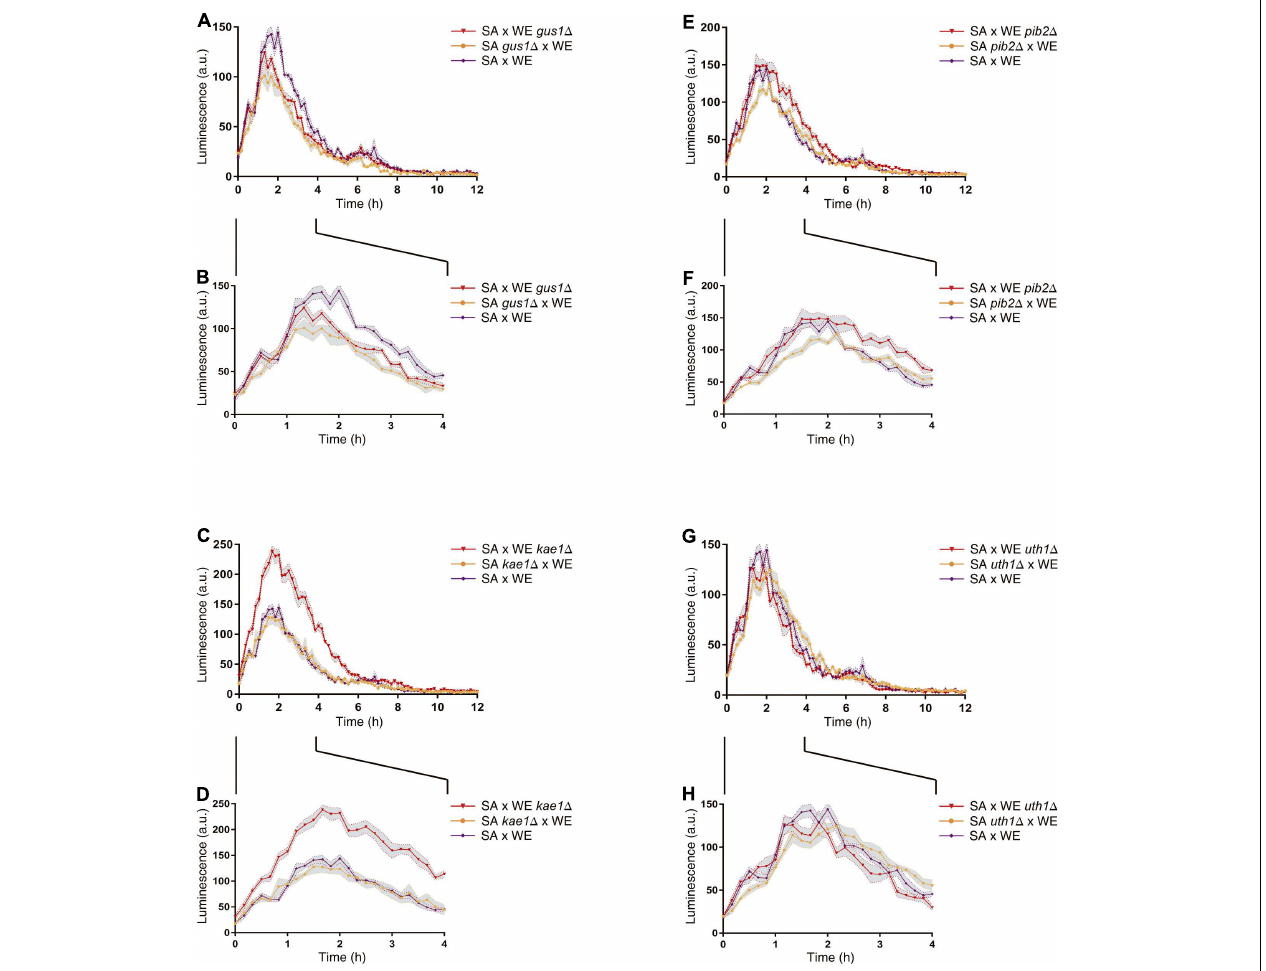
FIGURE 2 | Reciprocal hemizygosity analysis by nitrogen upshift experiments in microculture. Luminescence differences between reciprocal hemizygous strains for the genes GUS1 (A,B) , KAE1 (C,D) , PIB2 (E,F), and UTH1 (G,H) were evaluated in microculture conditions after a pulse of glutamine. The luminescence was recorded until 12 h after the nitrogen pulse (A,C,E,G) . Zoom-in of the first 4 h after the nitrogen (proline-to-glutamine) upshift experiment (B,D,F,H) . In all panels (A–H) , the time 0 h corresponds to the addition of glutamine. Plotted values correspond to the average of three biological replicates, with their standard error represented by shadow regions (mean ± SEM).